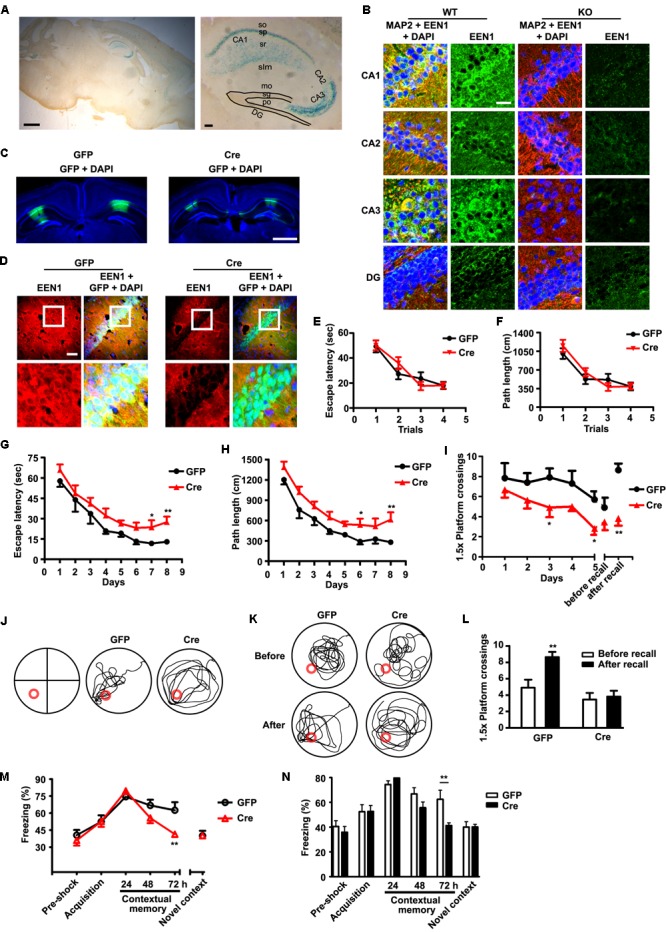
EEN1 expression in the hippocampal CA1 region of adult mice is required for long-term spatial and contextual fear memory. (A) LacZ staining in the sagittal brain section of 10-week-old EEN1 KO-first (EEN1-/-) mice. Right panel is magnification of the hippocampus. Scale bars, 1 mm in the left panel and 100 μm in the right panel. (B) Immunofluorescence staining of EEN1 in hippocampal CA1, CA2, CA3, and DG regions of 10-week-old EEN1+/+ and EEN1-/- mouse brains. Scale bar, 20 μm. (C) AAV virus was stereotaxically injected into the CA1 regions of EEN1fl/fl mice to express GFP alone or Cre and GFP. Shown are GFP signal and DAPI labeling of nuclei 21 days after viral injection. Scale bar, 1 mm. (D) Immunofluorescence staining of EEN1 in brain slices 21 days after injection of AAV virus into the CA1 region of EEN1fl/fl mice. Lower panels are magnification of the boxed areas. Scale bar, 100 μm. (E–L) The Morris water maze test. Shown are escape latency or traveled distance before escaping to the platform in the visible-platform training (E and F), escape latency, and traveled distance before escaping to the platform in the invisible-platform training (G and H), number of crossing with the 1.5× platform area and the swim trace 5 days after training in probe test (I and J), the swim trace and recall ability following training once again 1 month after training (K and L). Data represent mean ± SEM (11 GFP, 13 Cre), ∗p < 0.05, ∗∗p < 0.01. (M and N) Decrease in freezing behavior 72 h after contextual fear training in the Cre virus-injected group. Data represent mean ± SEM (9 GFP, 12 Cre), ∗∗p < 0.01.